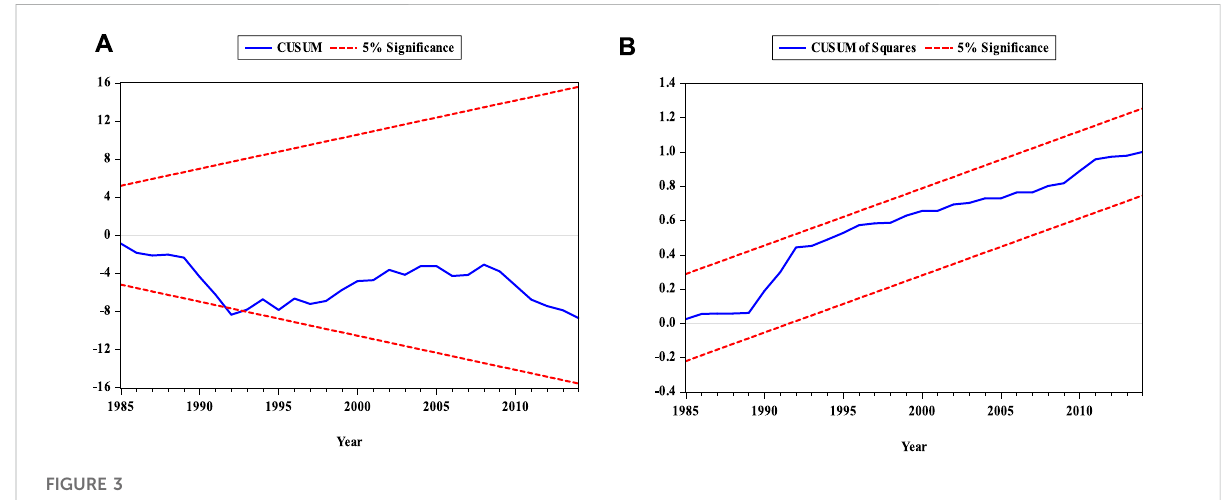
FIGURE 3 Stability test based on (A) CUSUM and (B) CUSUM of squares.